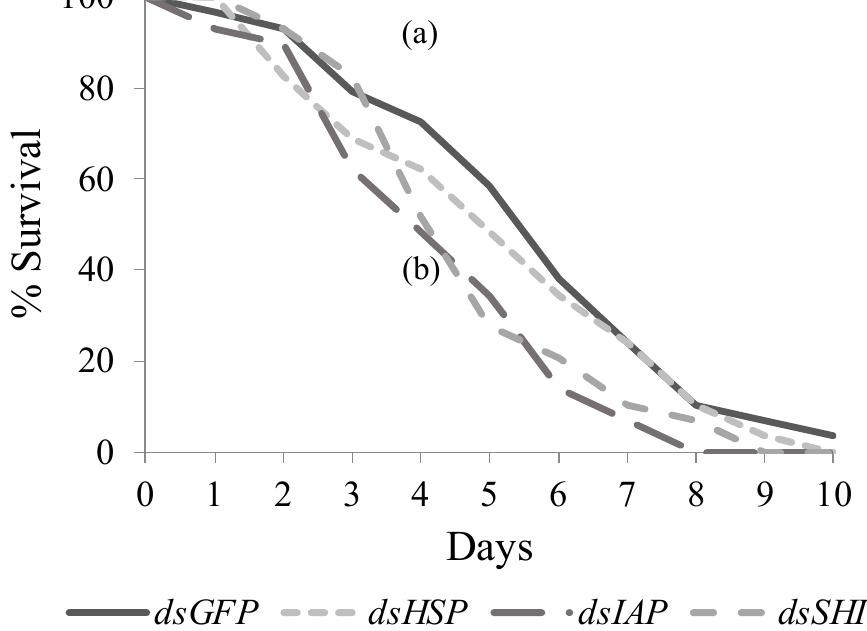
Figure 2. Beetle survival 10 days after exposure to 10 µ g of target dsRNA (dsHSP, dsIAP, and dsSHI), and a negative control (dsGFP). The dsGFP treatment ( a ) differs significantly from dsIAP and dsSHI ( b ) but not from dsHSP.